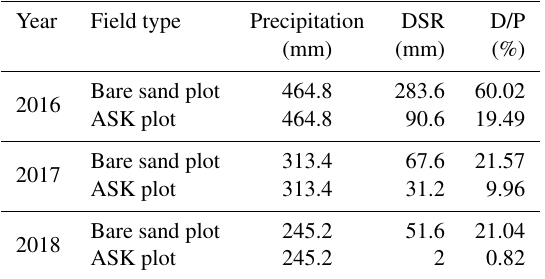
Table 3. Comparison of precipitation and DSR on the ASK land and bare sand